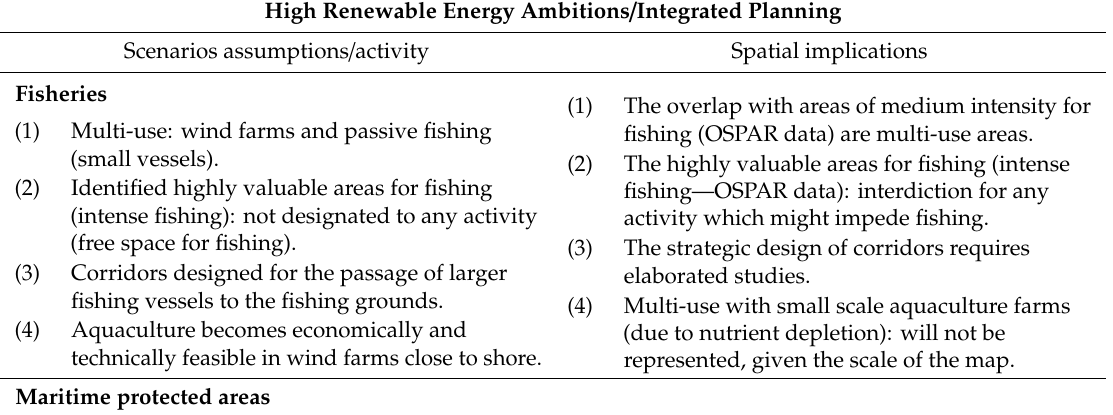
Table 6. Scenario A: High renewable energy ambitions / integrated